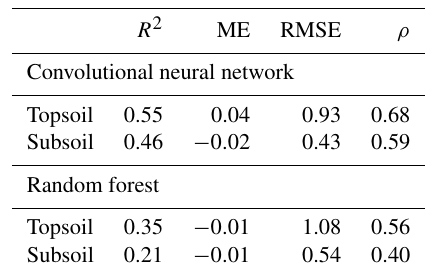
Table 3. Evaluation of prediction accuracy on the independent test set ( R 2 – coefficient of determination; ME – mean error,